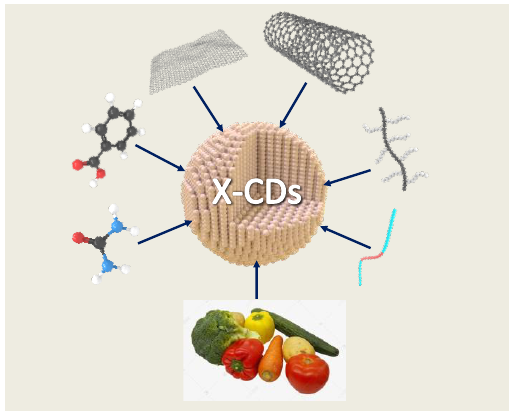
Figure 1. Various raw material sources used in the synthesis of CDs including small molecule com- pounds, polymers, carbon materials, fruits, and vegetables.